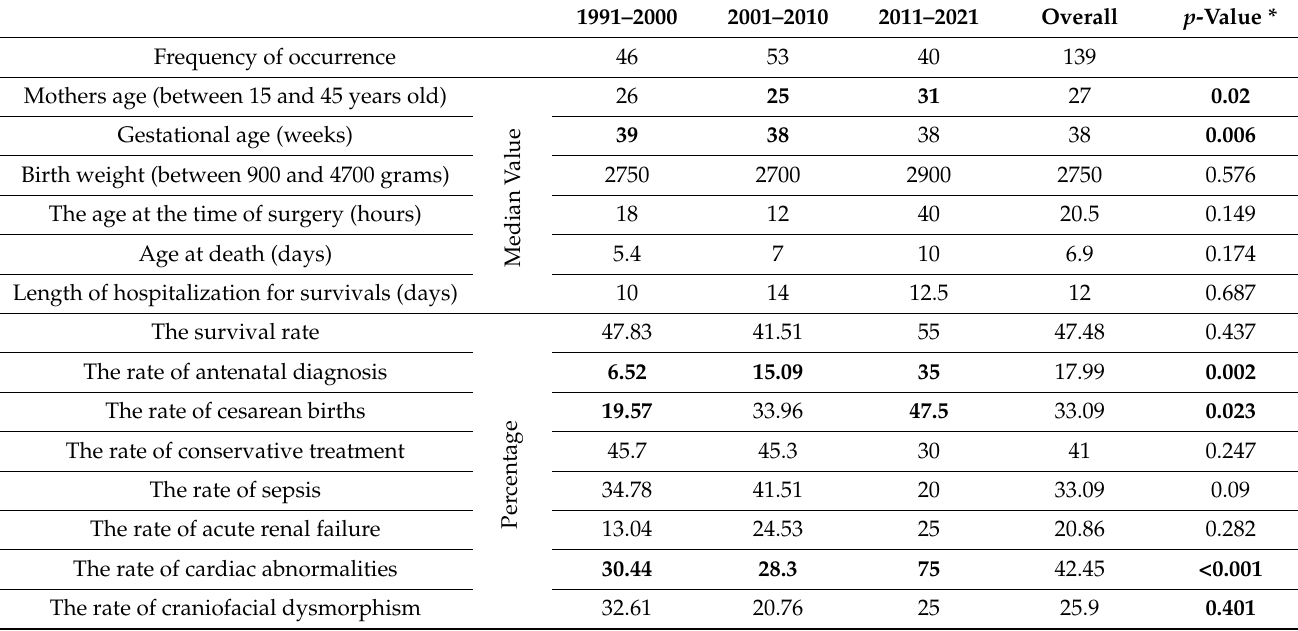
Table 1. Descriptive statistics of the analyzed patients.